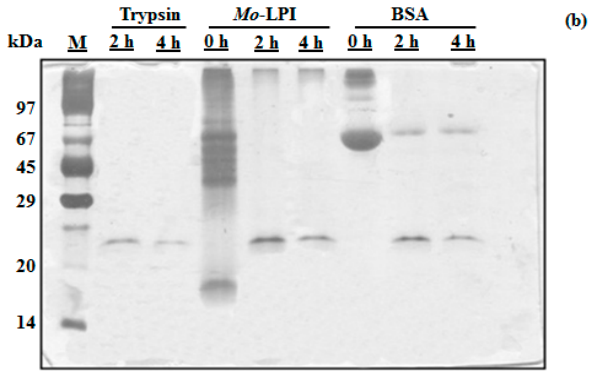
Figure 1. Assessment of the in vitro digestibility of Mo -LPI by SDS-PAGE analysis. Mo -LPI was incubated with pepsin or trypsin at different times (0, 2 and 4 h). ( a ) Pepsin digestion; ( b ) Trypsin digestion. Bovine serum albumin (BSA) was used as control. Twenty microgram from each sample were loaded in each well. Vertical numbers indicate the molecular mass markers: phosphorylase B (97 kDa); BSA (67 kDa); ovalbumin (45 kDa); carbonic anhydrase (29 kDa); trypsin inhibitor (20.1 kDa) and α -lactalbumin (14.2 kDa). Horizontal numbers refer to the digestion times (h). Mo -LPI could not agglutinate rabbit erythrocytes, even at 6 mg/mL. However, agglutinating